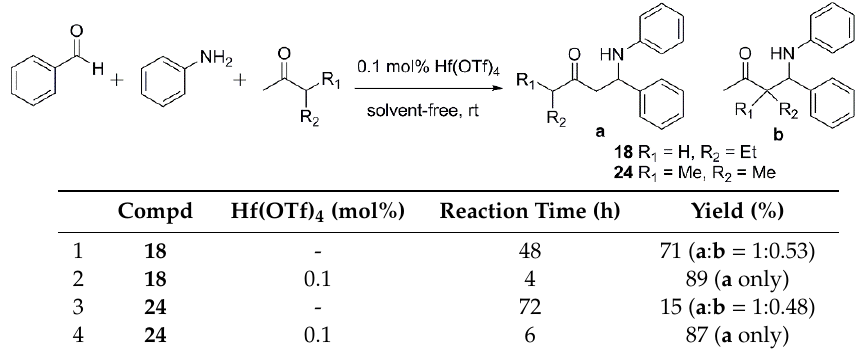
Table 3. The regioselectivity of Hf(OTf) 4 -catalyzed synthesis of Mannich bases 18 and 24 a .